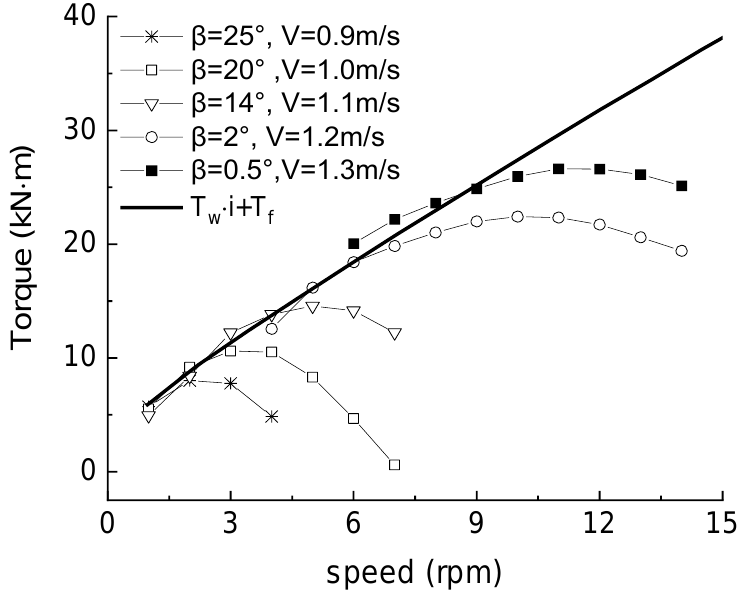
Figure 8. Torque characteristics of the impeller with different pitch angles under the low-flow velocity condition.